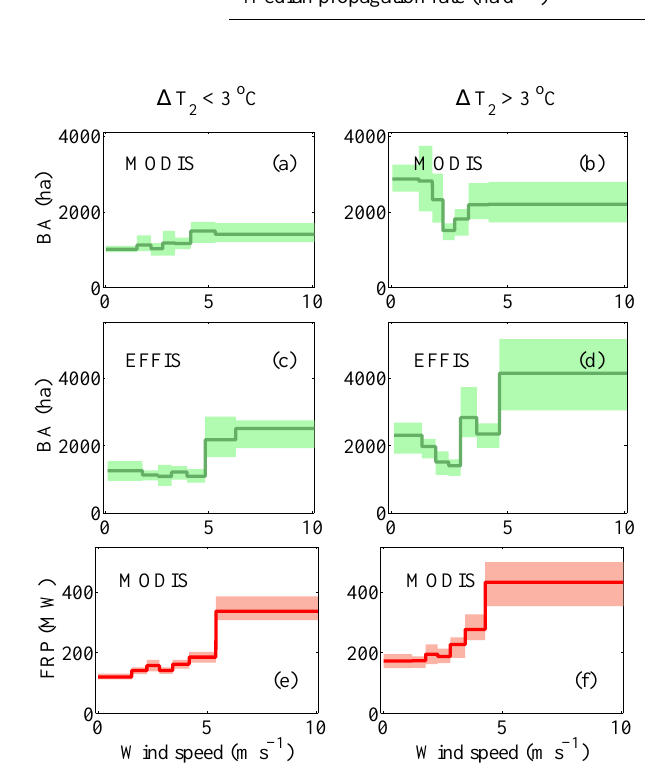
Figure 3. Burnt area (BA) at the end of the fire (upper and mid- dle rows, a , b , c and d ) and fire radiative power (FRP) at the fire mature stage (first day) (lower row, e and f ) with respect to the 10m wind speed at 12:00UTC on the first day of each fire over the whole Mediterranean region. For BA the upper row corresponds to the MODIS data set and the middle row to the EFFIS data set. The solid line represents the 95th quantiles ( q 95 ) of BA (upper and middle row) and FRP (lower row). The green shaded area repre- sents the 70% confidence intervals (BA) and the red shaded area the 90% confidence intervals (FRP). The quantities BA and FRP are clustered in two categories of 2m temperature anomaly with re- spect to the climatology ( (cid:49)T 2 ), i.e. (cid:49)T 2 < 3 ◦ C (left column) and (cid:49)T 2 > 3 ◦ C (right column). For each subfigure the data are sepa- rated in seven bins of equal number of